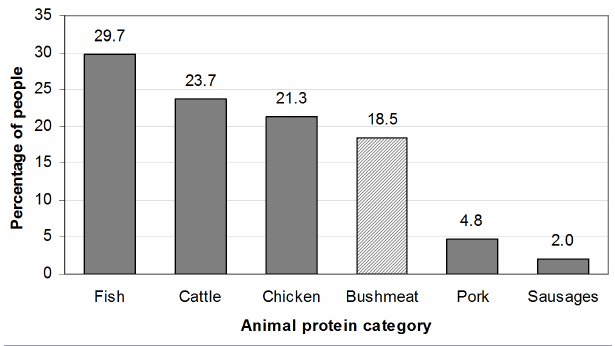
Fig. 3 . Preference according to the type of animal protein by individual.